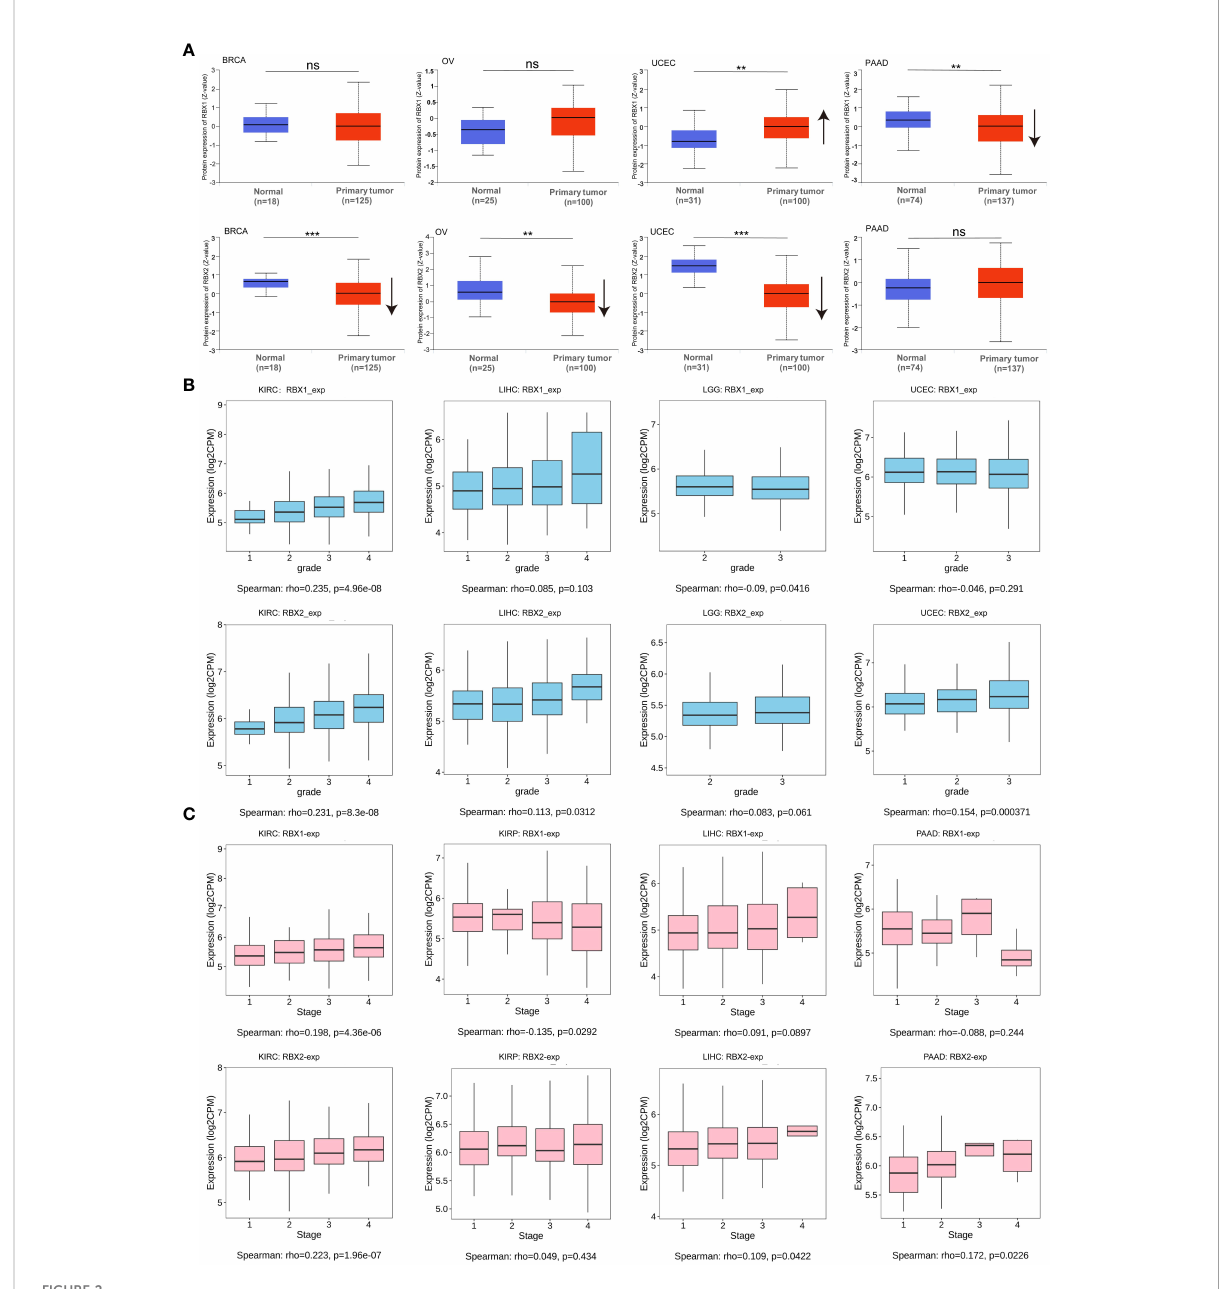
FIGURE 2 RBX1/2 expression based on tumor types and individual pathological grades and stages. (A) RBX-proteins expression in BRCA, OV, UCEC and PAAD. ns is considered as no statistical difference, ** P < 0.01, *** P < 0.001. Up or down arrow represented the expression of tumor samples more or less than the corresponding normal samples, respectively. (B) The expression levels of RBX1/2 were analyzed by tumor pathological grades (grade1, grade2, grade3, grade4) of KIRC, LIHC, LGG and UCEC. P value less than 0.05 is considered as difference. (C) The expression levels of RBX1/2 were analyzed by tumor pathological stages (stage I, stage II, stage III, and stage IV) of KIRC, KIRP, LIHC and PAAD. P value less than 0.05 is considered as